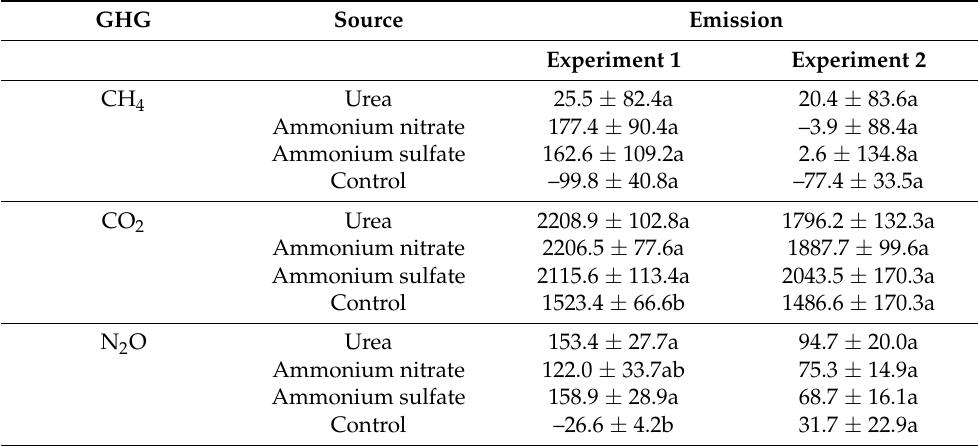
Table 3. Cumulative CH 4 (mg CH 4 m − 2 ), CO 2 (mg CO 2 m − 2 ), and N 2 O (mg N 2 O m 2 ) emissions from Marandu pastures fertilized with different N sources and doses in two experiments.